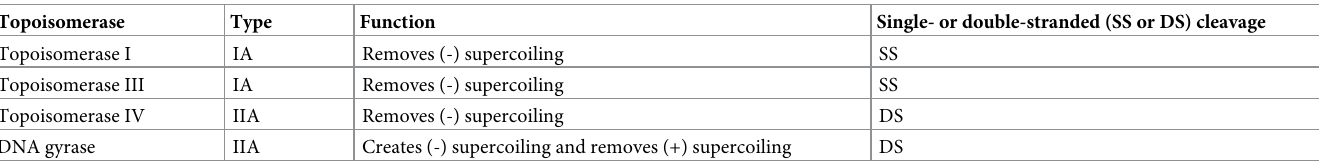
Table 3. E . coli DNA